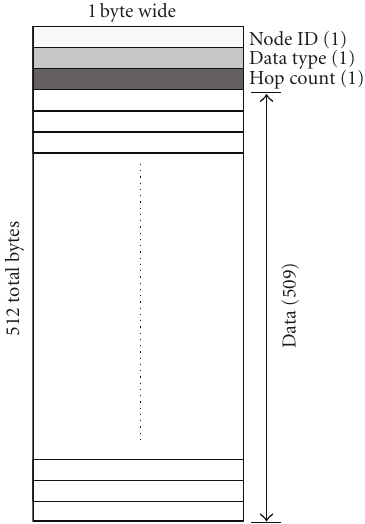
Figure 5: Collar data segment. These segments are stored in the FIFO bu ff ers of the microSD card. Numbers in parentheses are